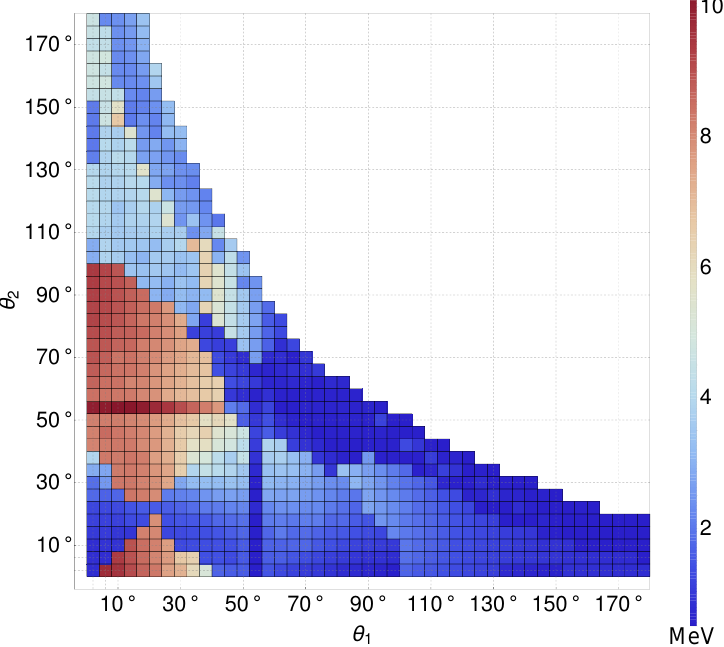
Figure 3: The distribution of the outgoing neutron energy E responding to the maximal ∆ SIGS in the cross section distribution (see Fig. 1) for the deuteron breakup process at E = 13